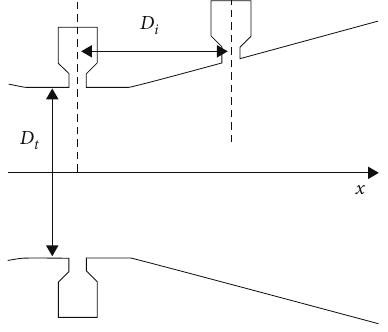
Figure 2: Schematic diagram of injection port